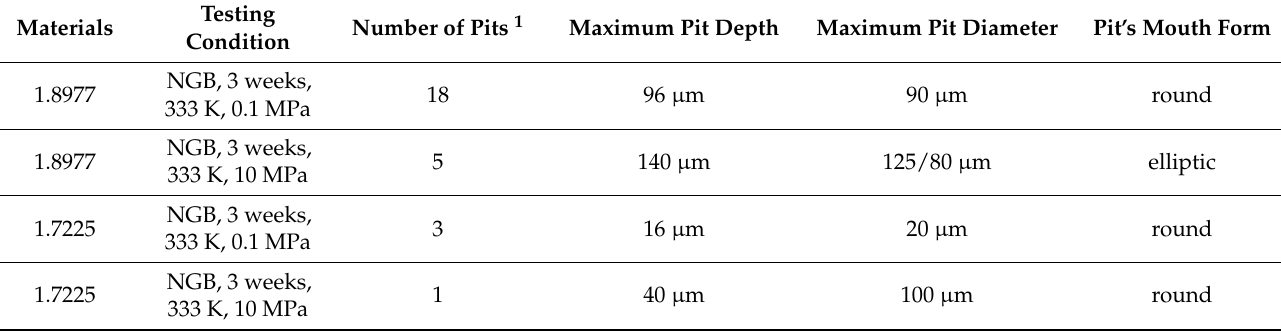
Table 3. Pitting analysis of each steel under different testing